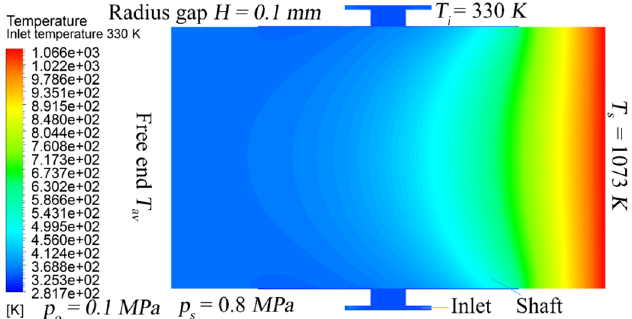
Fig. 19. Temperature contours of the fl ow and shaft domain showing the heat dissipation of the CO 2 fl ow for 16-jet at p s